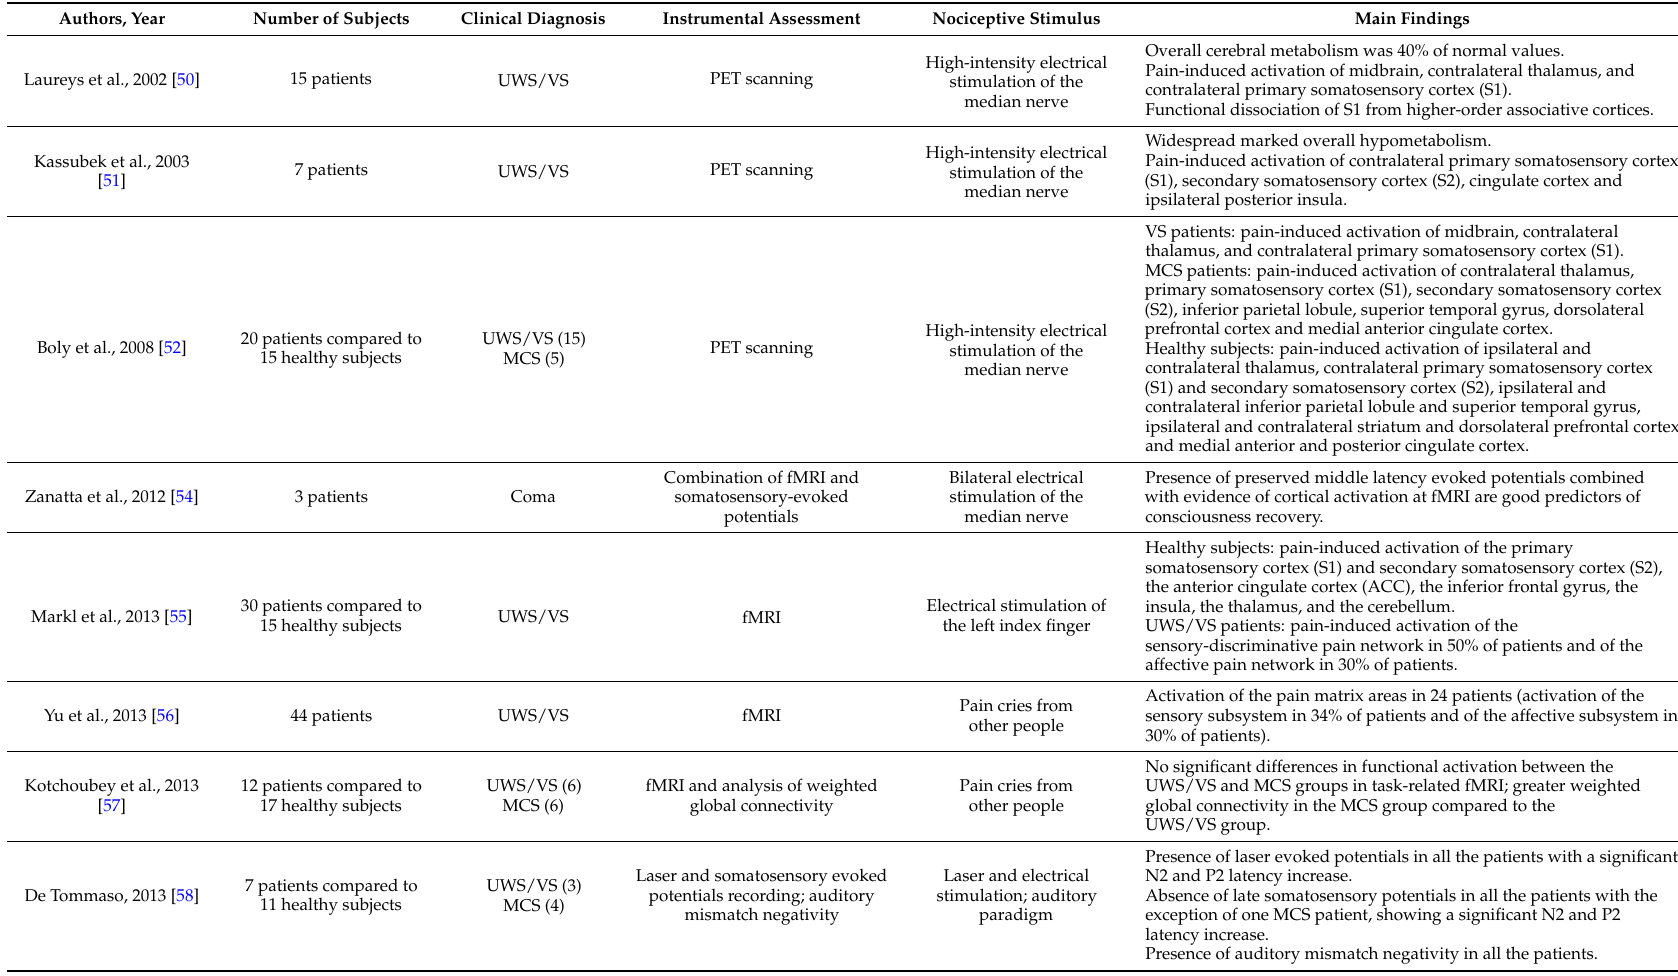
Table 1. Main neuroimaging studies investigating pain perception in patients with disorders of